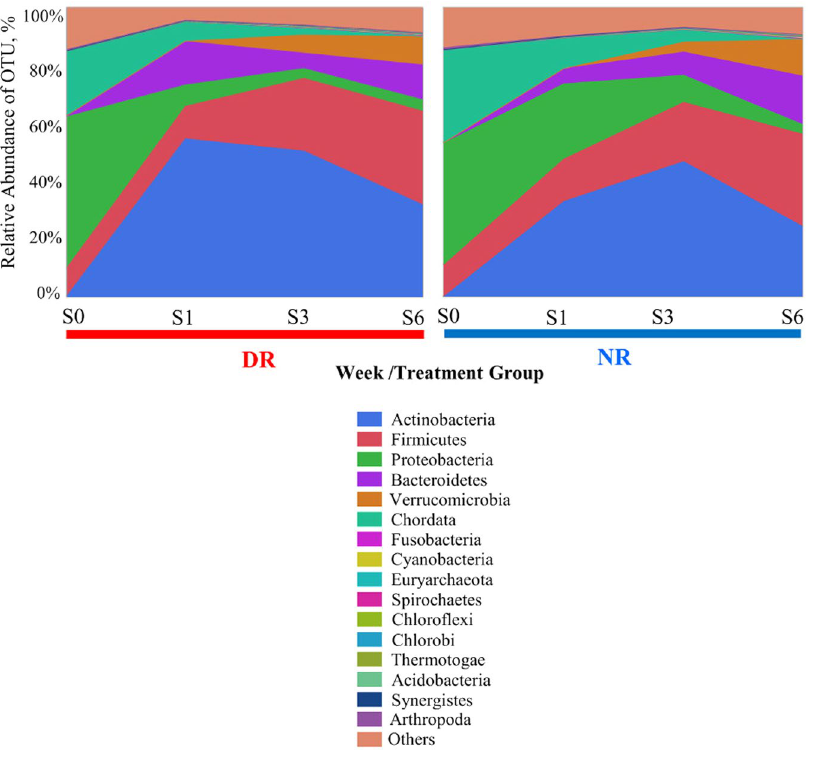
Figure 7. Average percentage of the 16 most prevalent phyla for each treatment group by week of sampling.